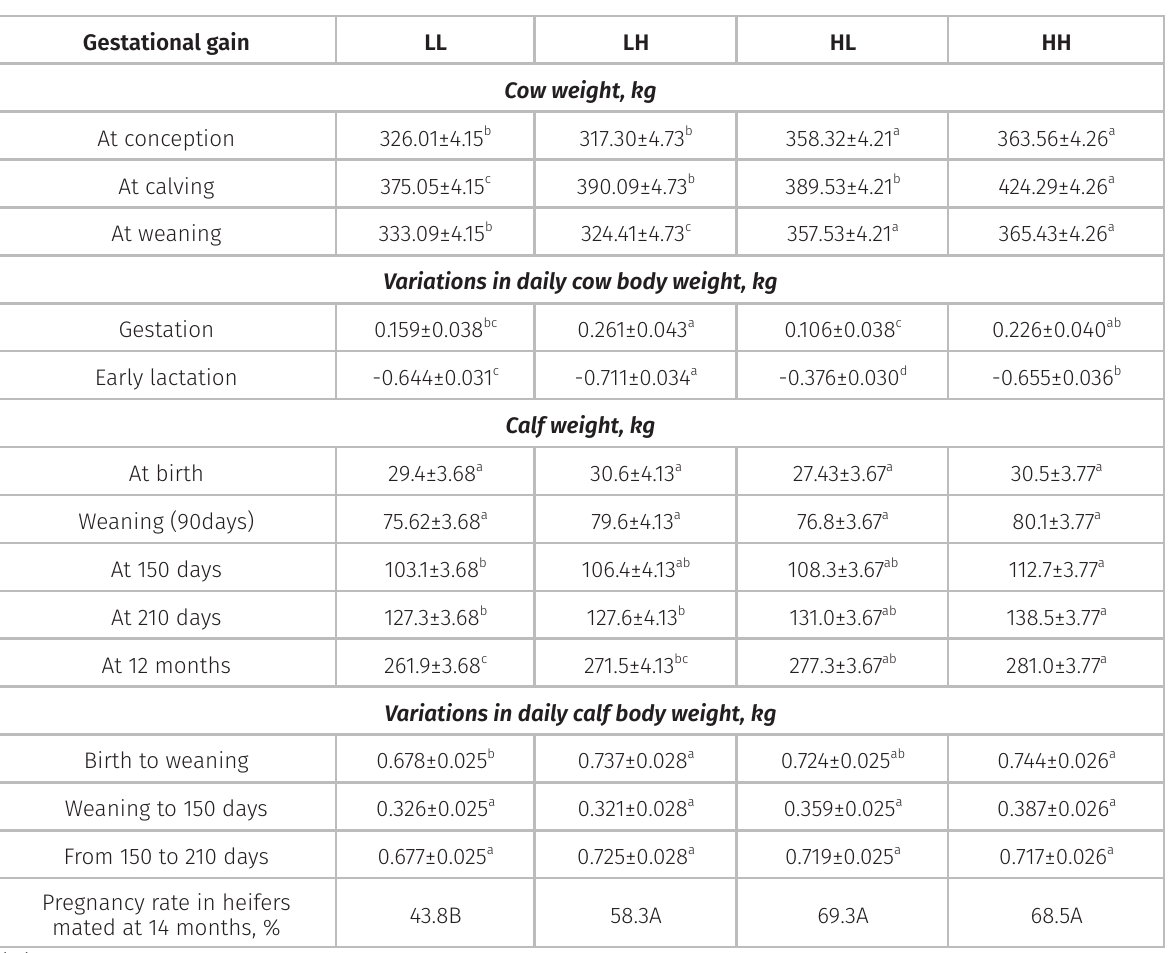
Table I. Adjusted mean values and standard errors for the developmental variables of cows and their calves based on primiparous cow weight at conception and weight gain during the second